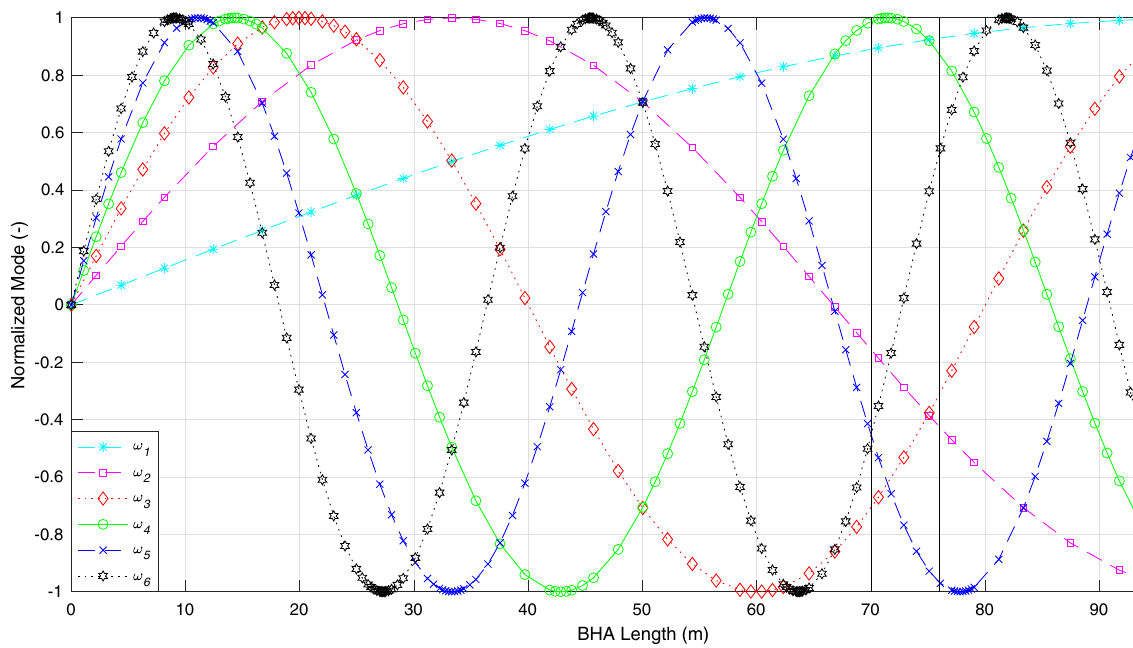
Fig. 3 First six mode shapes Fig. 4 Torsional response